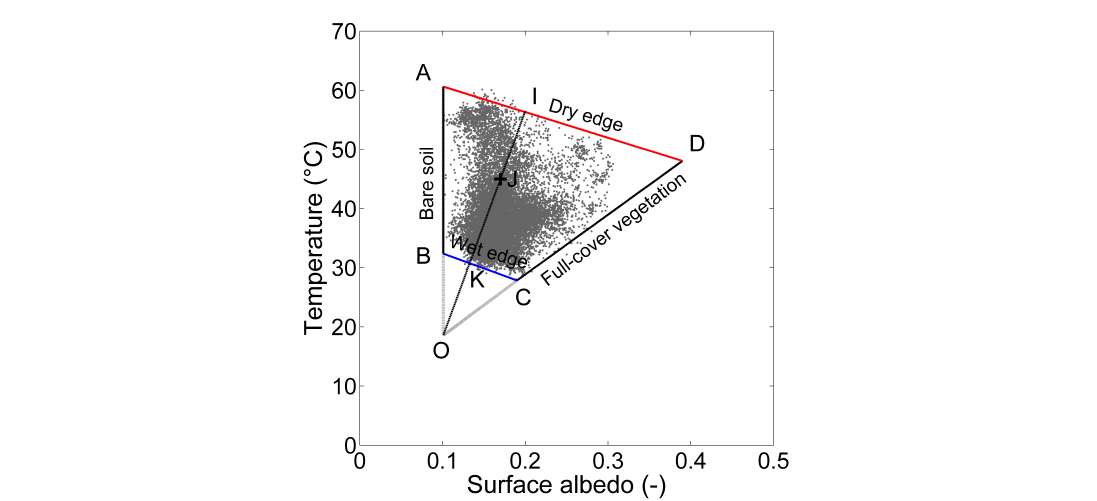
Figure 4. For a given J point, EF is computed as the ratio of IJ to IK. Underlying grey points correspond to 90-m resolution data acquired on 27 April, over the Yaqui